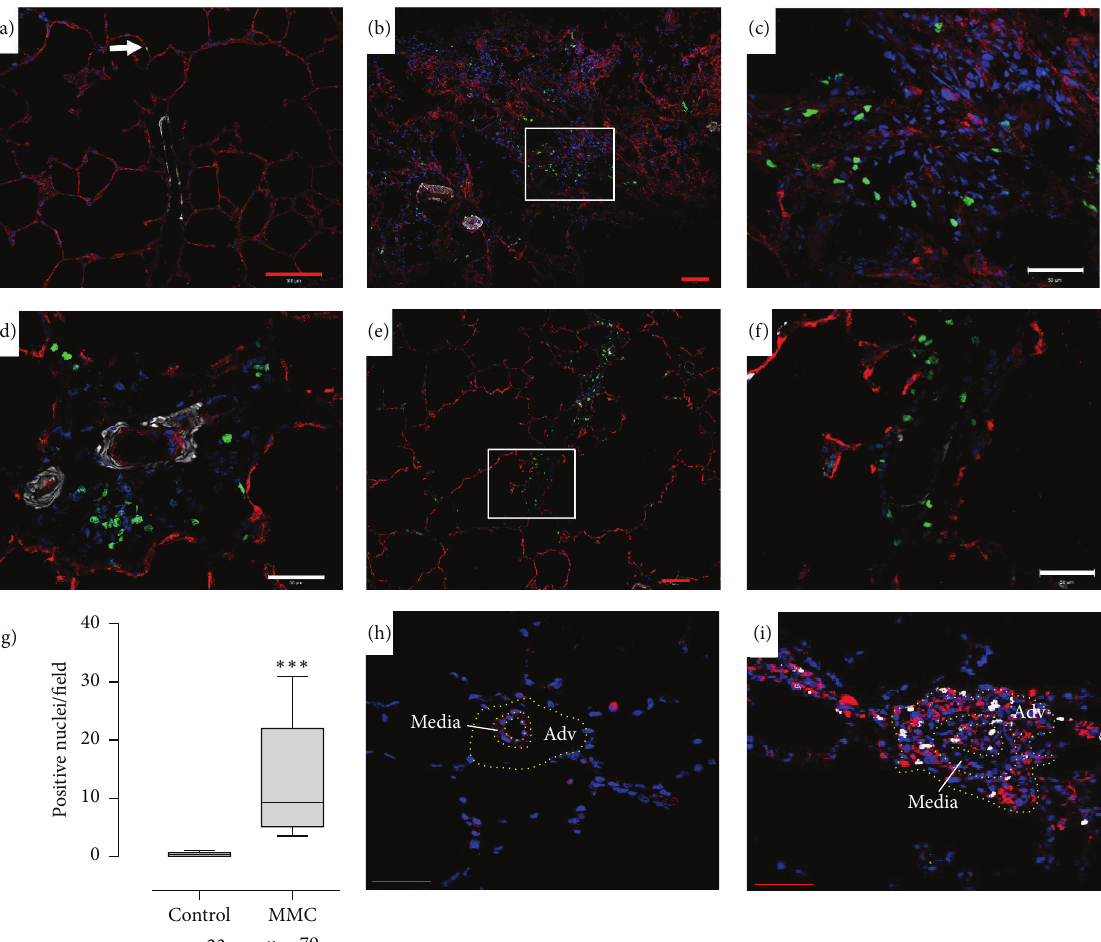
Figure 2: MMC-exposed rat lungs display areas of intense microvascular endothelial cell proliferation. Immunofluorescent staining of frozen rat lung sections and confocal imaging. Red: CD34 (endothelial cells). White: 𝛼 -smooth muscle actin (smooth muscle cells). Green: click- iT EdU stain (nuclei of proliferating cells). Counterstain = 4 󸀠 ,6-diamidino-2-phenylindole (DAPI). (a) Control rat lung. ((b)–(f)) MMC- exposed rat lung. (a) Control rat lung parenchyma displays very little microvascular endothelial cell proliferation. Note a single endothelial cell in proliferation (arrow). ((b)-(c)) Pulmonary capillary hemangiomatosis like foci from MMC-exposed rats display intense microvascular endothelial cell proliferation. (d) Adventitial fibroblast cells proliferation in small remodeled pulmonary artery. ((e)-(f)) Adventitial fibroblast cells proliferation in small remodeled pulmonary vein. (g) Quantification of the percentage of lung proliferating cells. ((h)-(i)) Exuberant adventitial fibroblast cell proliferation in MMC-exposed rats (i) compared to control rats (h) (Vimentin+EdU+ cells). Adventitial fibroblast cells were stained with antibody against Vimentin (fibroblast marker in red) and proliferative cells with click-it EdU (white nuclei = EdU positive nuclei = proliferating cells). Vessel media and adventitia (Adv) were delimited by the yellow dotted line area. ∗∗∗ 𝑃 < 0.001 . Red scale bar = 100 𝜇 m. White scale bar = 50 𝜇